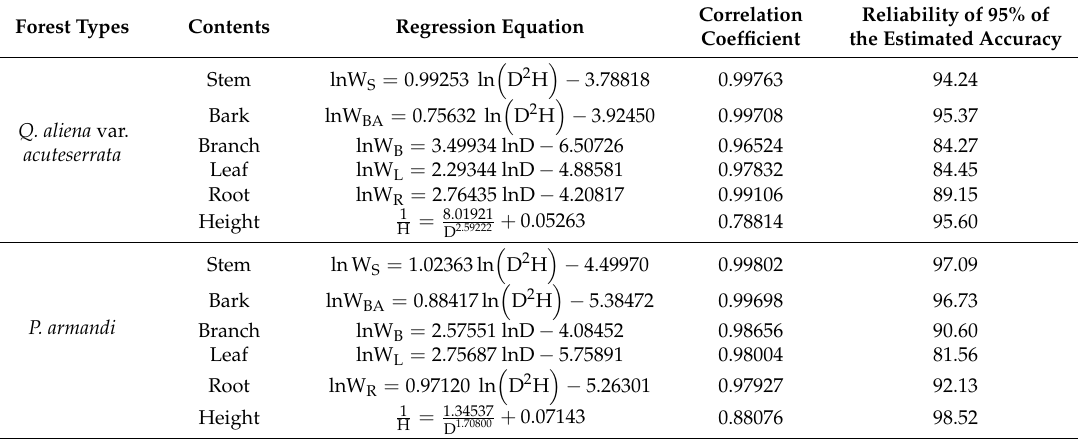
Table 3. The regression model of biomass and height in P. armandi and Q. aliena var. acuteserrata forests in the Huoditang Experimental Forest Farm in the Qinling Mountains